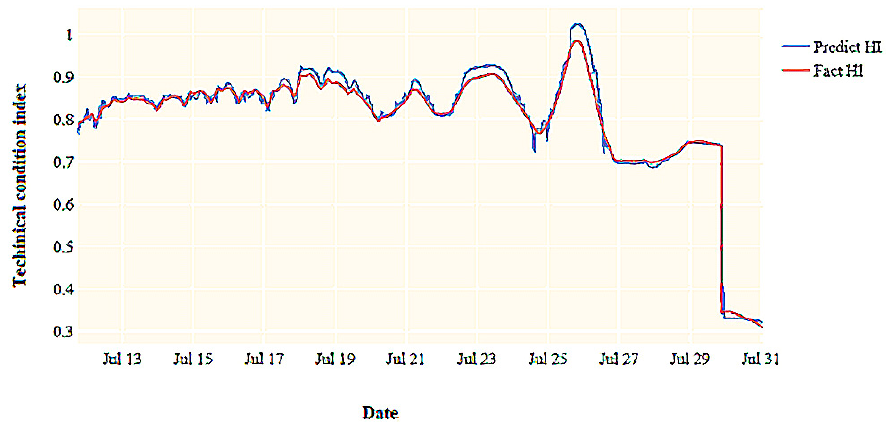
Figure 6. Changes in the predicted values of the technical condition index on the training set in comparison with real data (time shift—3 h).